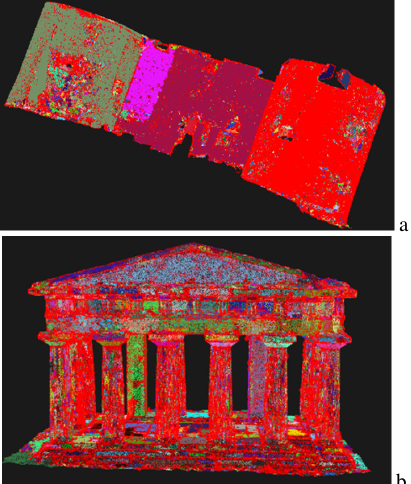
b Figure 8. The segmentation of a) the Château d’If point cloud with max cluster num. 100; b) Temple of Neptune with max cluster num. 100k.